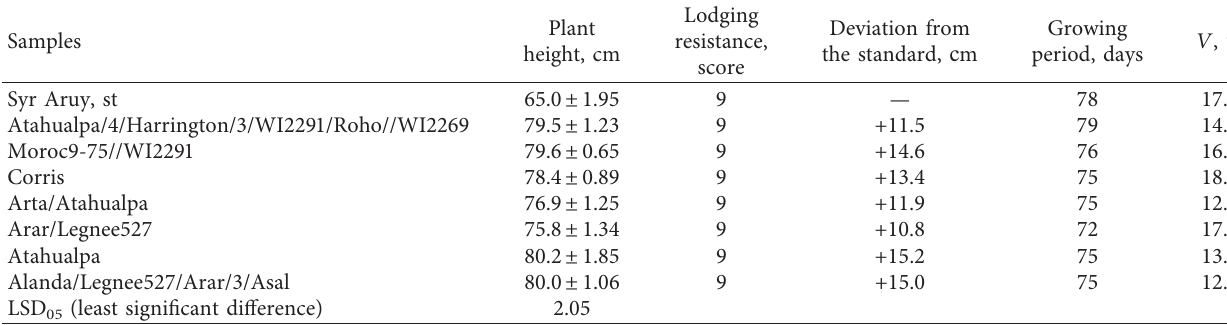
Table 3: Sources of lodging resistance in combination with early maturation (2017–2019). Samples